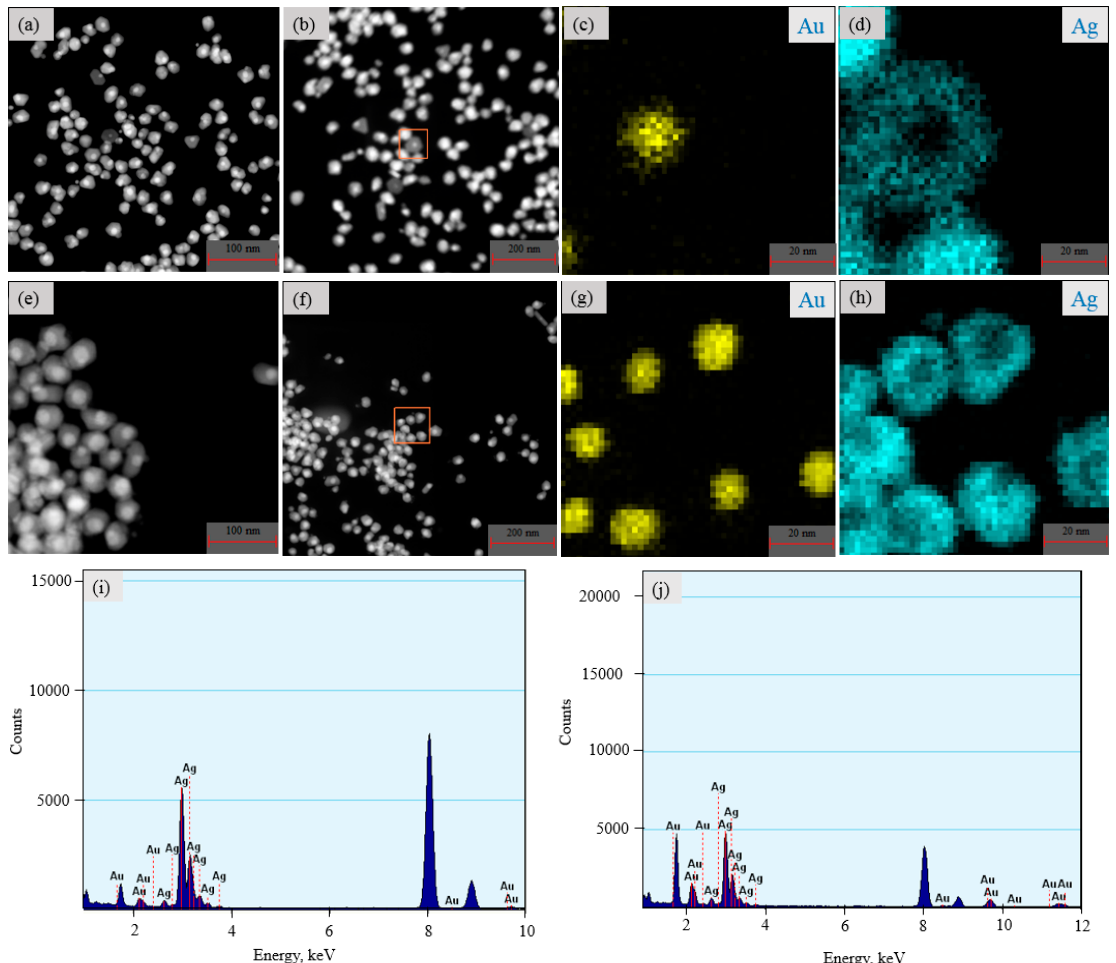
Figure 6. HAADF-STEM images of ( a , b ) 2.0 mL Au seeds, ( e , f ) 5.0 mL Au seeds, EDS mapping analysis ( c , d , i ) 2.0 mL Au seeds, and ( g , h , j ) 5.0 mL Au seeds of Au-Ag nanoparticles.